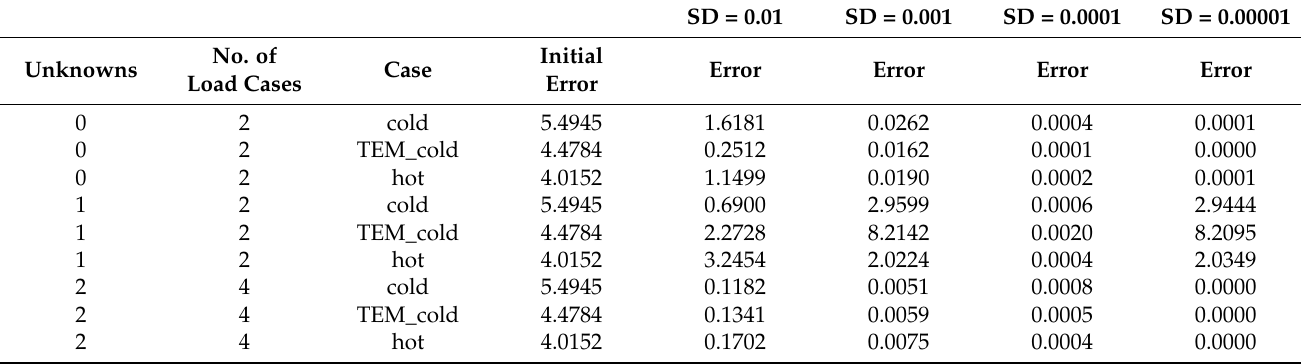
Table 10. Errors for predicted temperatures for transient 7 nodes